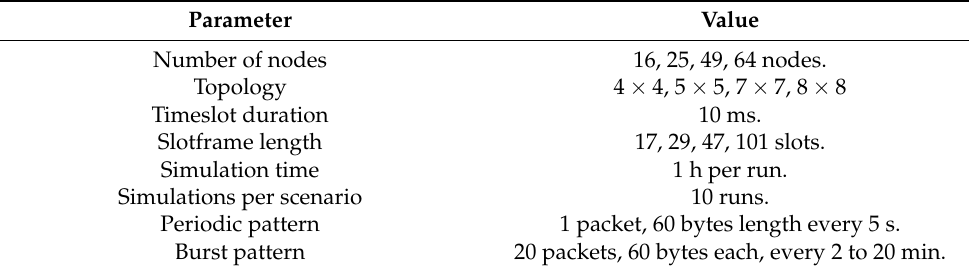
Table 2. Simulation parameter